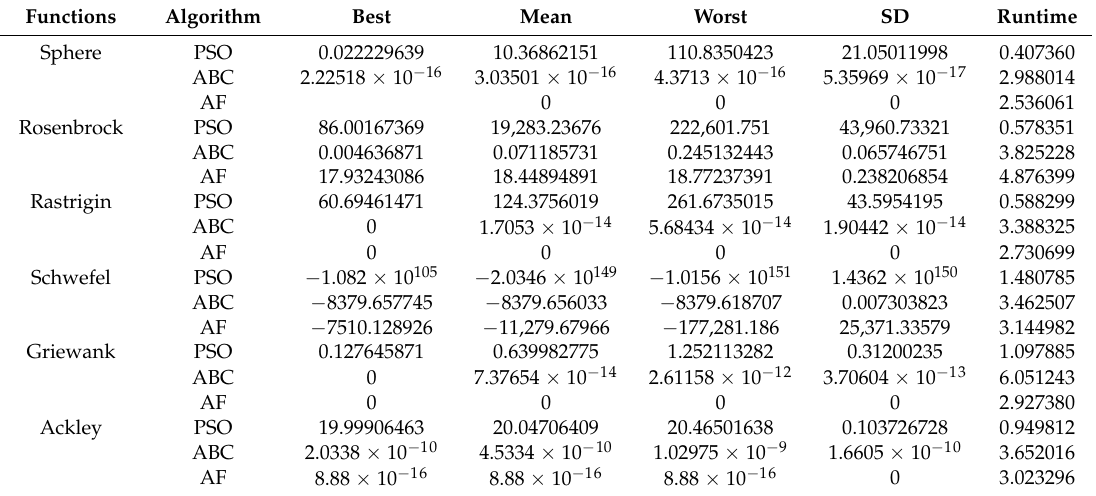
Table 5. Comparison of statistical results obtained by AF, PSO, and ABC in 20-dimensional space.